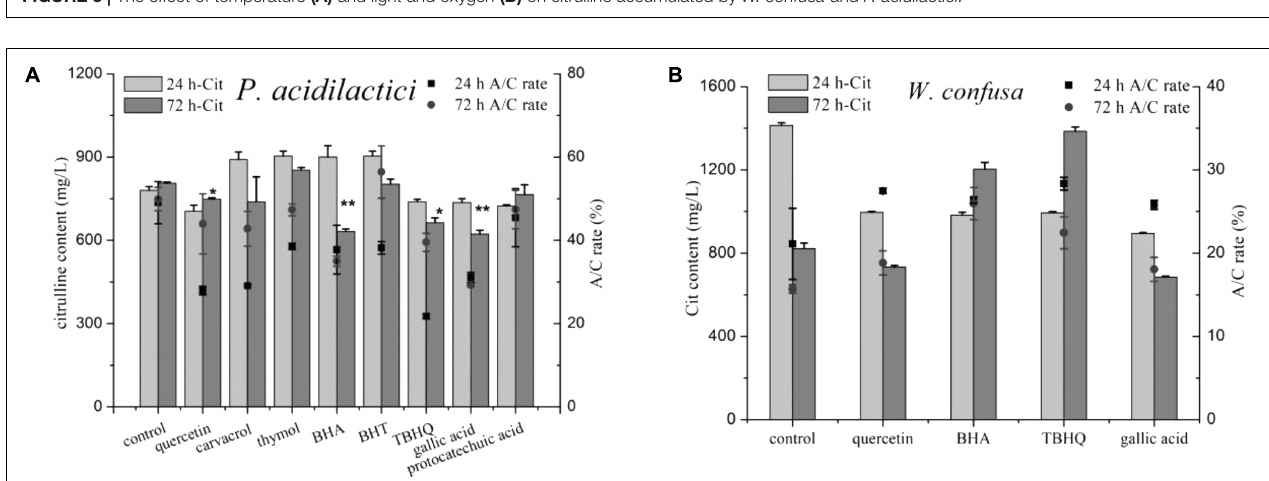
FIGURE 5 | The effect of temperature (A) and light and oxygen (B) on citrulline accumulated by W. confusa and P. acidilactici.